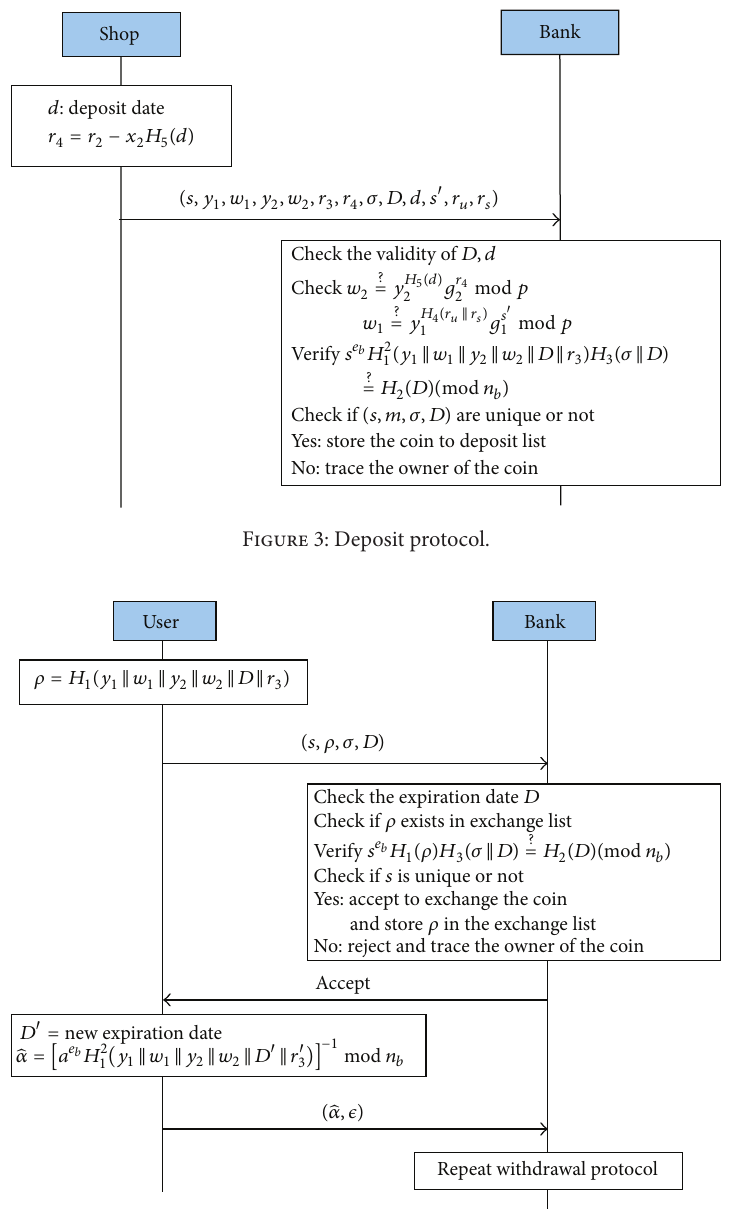
Figure 4: E-Cash renewal